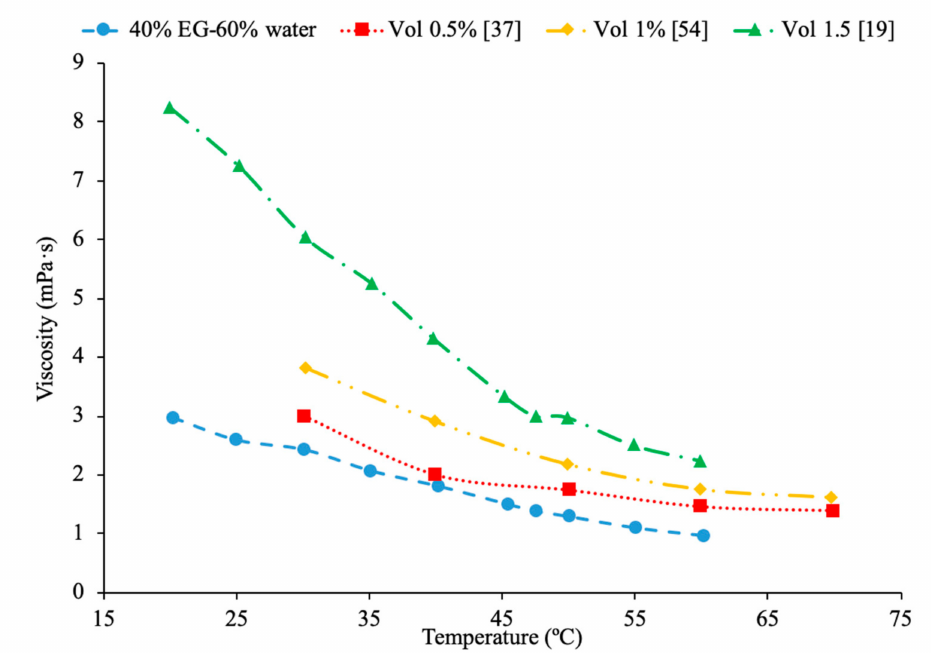
Figure 16. Viscosity as a function of temperature for various Al 2 O 3 -40% ethylene glycol (EG)-60% water volume concentrations